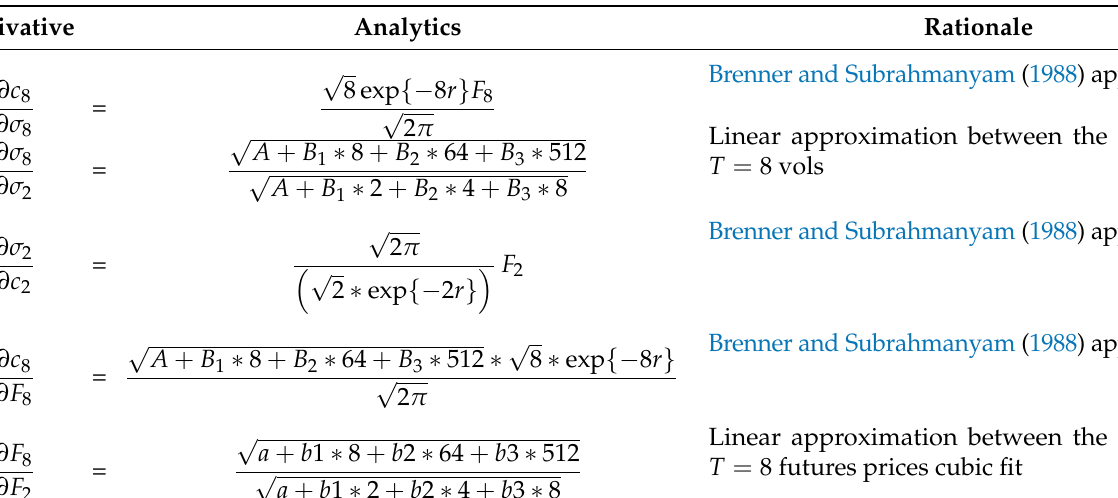
Table 4. Hedge portfolio for T = 8